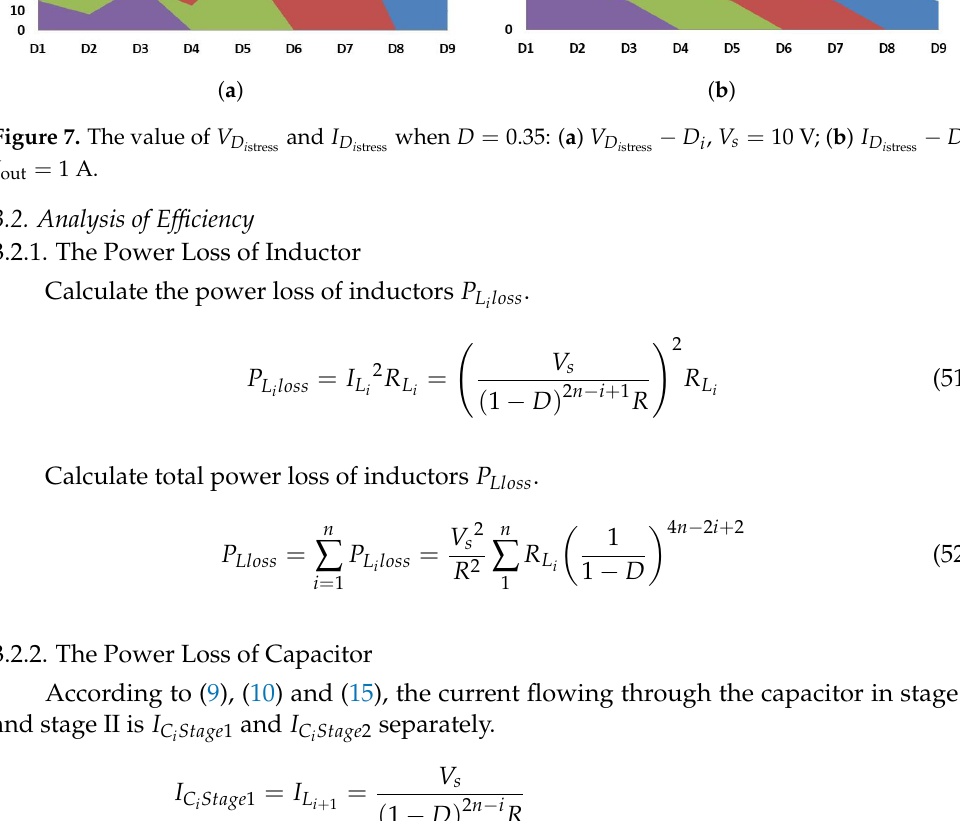
and I D when D = 0.35: ( a ) V D i stress i stress